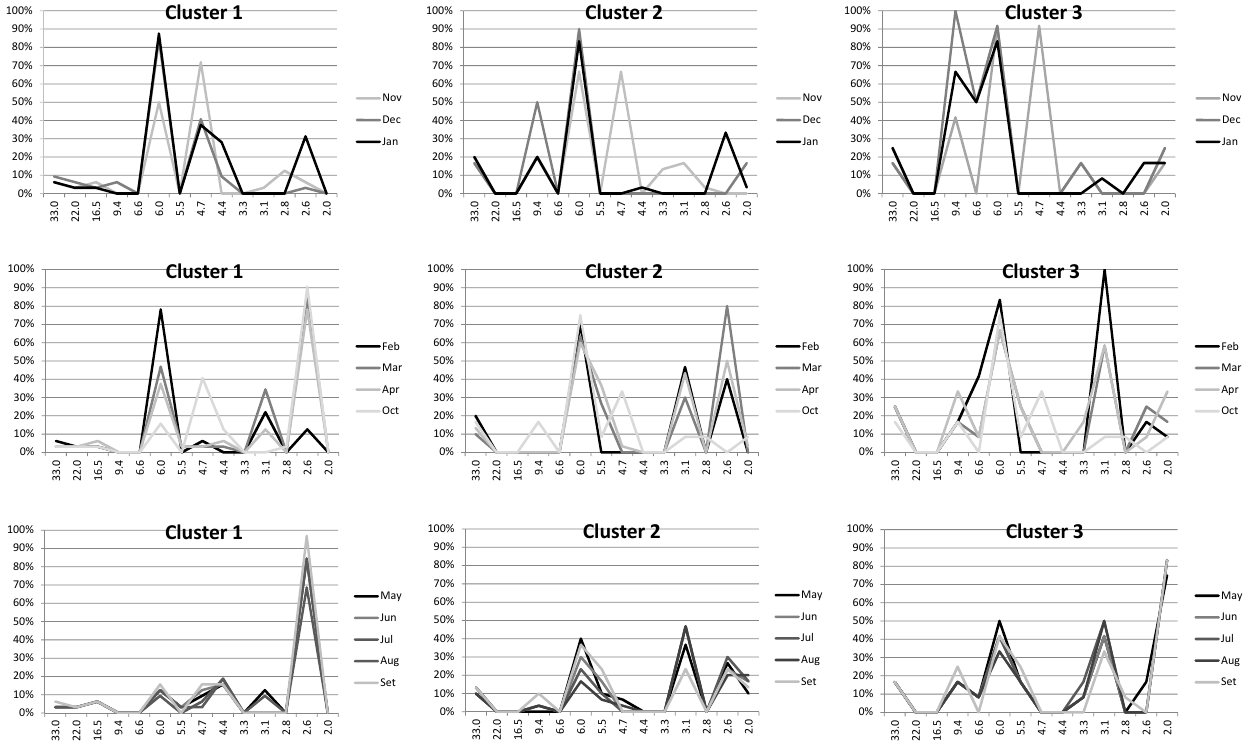
Figure 7. Frequencies relative to each cluster per period cycle, gathered in three groups: November, December and January (wet season); February, March and April (transition months); and May–September (dry